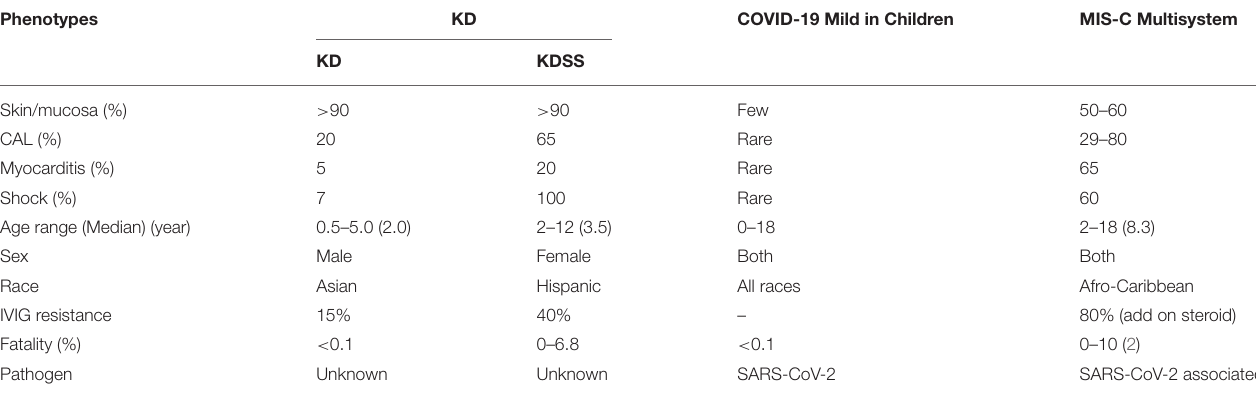
TABLE 1 | Demographic data and phenotypes of Kawasaki disease (KD) and multisystem inflammatory syndrome in children